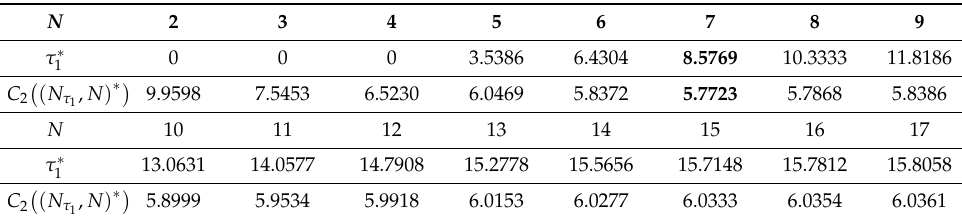
Table 3. The optimal long-run average cost rates for different values of N .